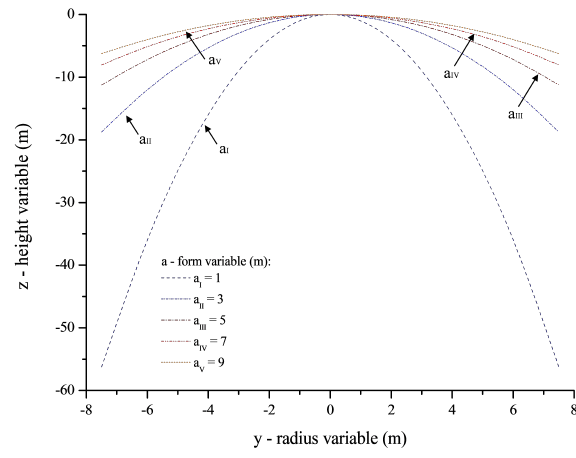
Table 1: Material properties of the ship structures.